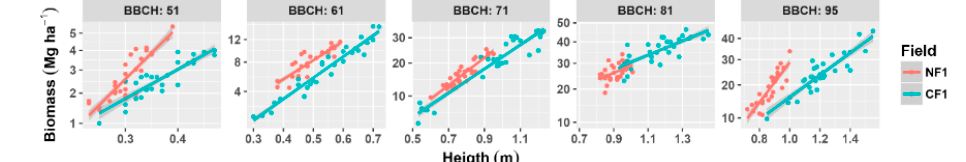
Figure 4. Relation of crop aboveground fresh biomass and crop height in five crop stages (BBCH) for cotton cultivated in two systems: narrow row (NF1) and conventional row spacing (CF1).